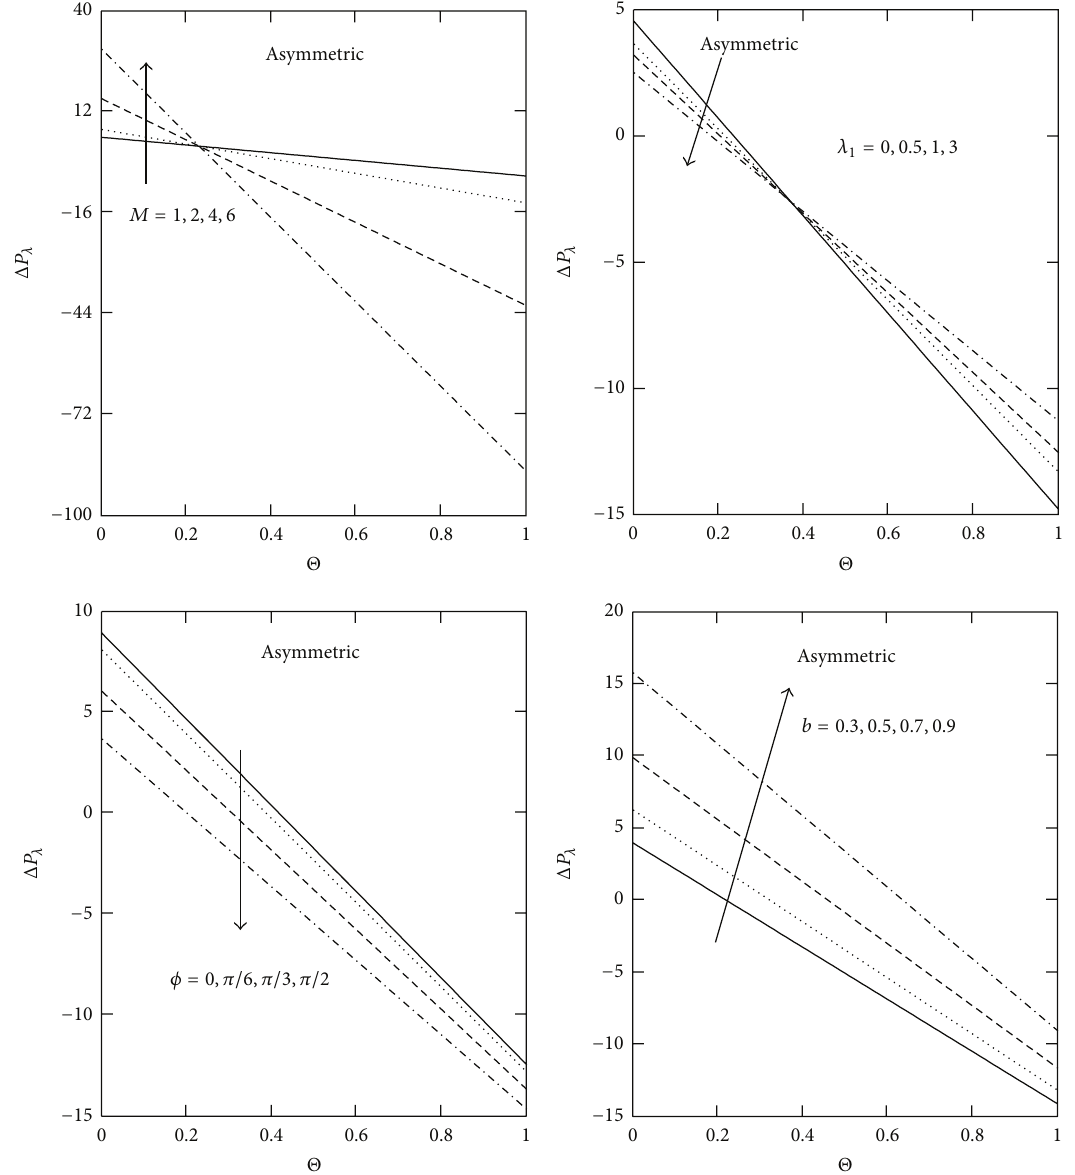
Figure 4: Variation of Δ𝑃 𝜆 with influence of 𝑀 , 𝜆 1 , 𝜙 , and 𝑏 with respect to Θ .